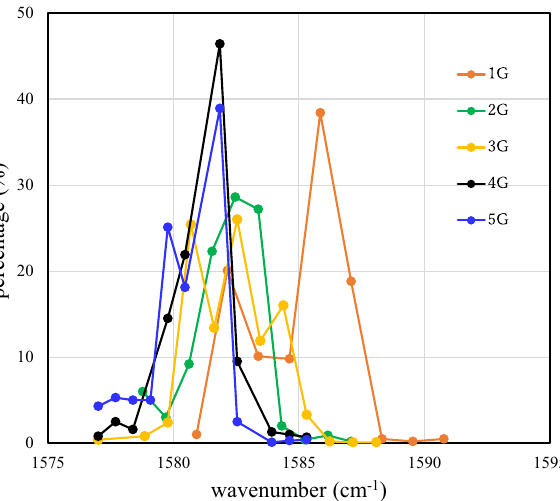
Figure 5. Percentage of the wavenumber of the G band for mono-, bi-, tri-, tetra-, and penta-layer graphene/ LiNbO 3 structures between 1575.0 cm